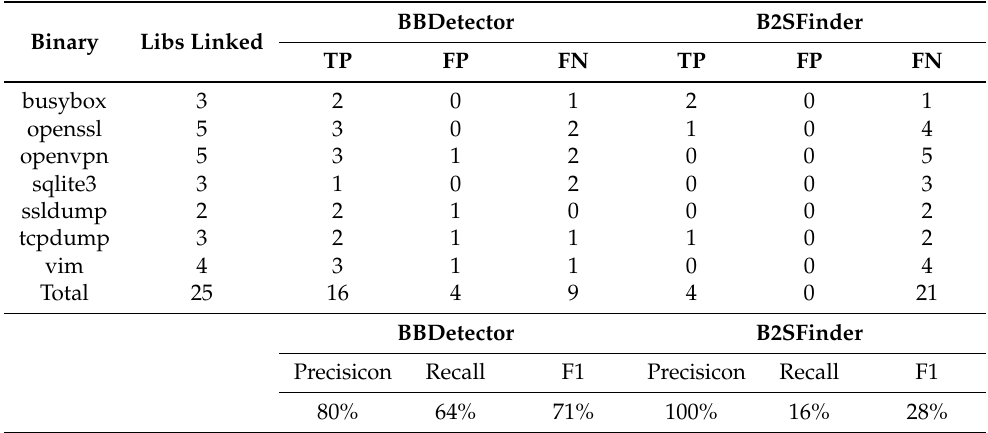
Table 7. TPL detection on obfuscation ubuntu binary